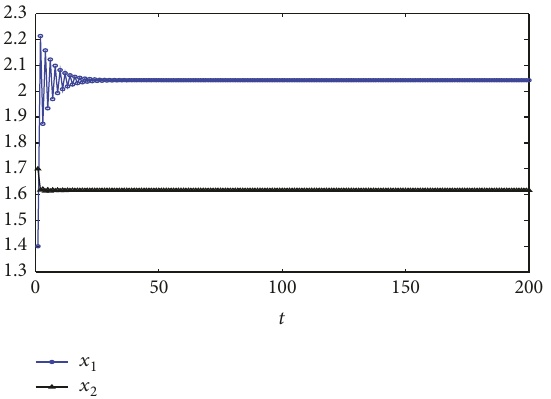
Figure 2: Time diagram of the input for (𝛼 1 = 0.92, 𝛼 2 = 0.36) .